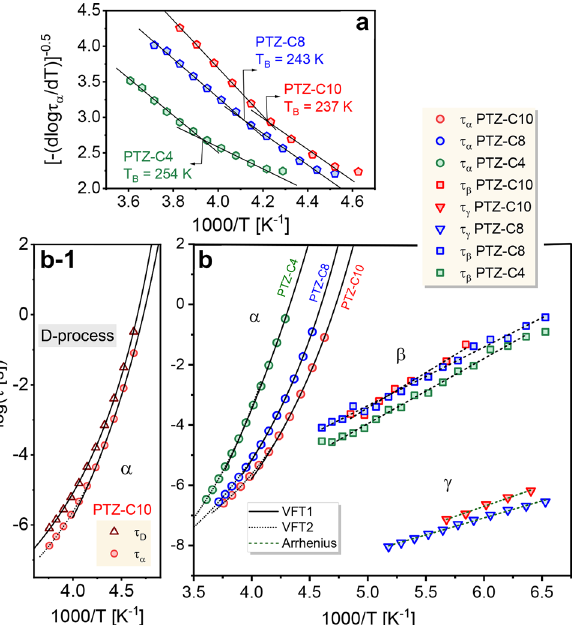
Figure 7. ( a ) The derivative analysis of the temperature dependence of structural relaxation times for PTZ derivatives. The crossover temperature T B was determined from the intersection of two straight lines in the low- and high-temperature regime. ( b ) A plot of log( τ ) versus the reciprocal of temperature for the respective relaxation times (circles correspond to α -process, squares to β -process, triangles to γ -process). ( b-1 ) The temperature evolution of relaxation times for slow and fast components according to the indication in Fig. 3b. The solid and dot lines denote the VFT fit function in the low and high-temperature regime according to the indication of the Stickel analysis; the dashed lines are the Arrhenius fits. The corresponding fitting parameters are summarized in Tables 1 and 2.